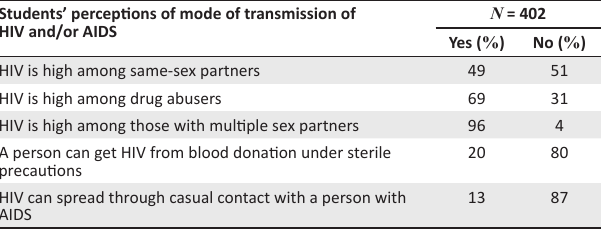
TABLE 1: Perceived mode of HIV infection and those perceived to be highly at risk. Students’ perceptions of mode of transmission of HIV and/or